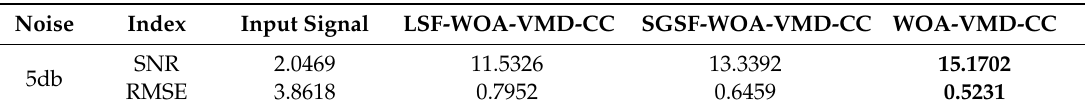
Table 4. Di ff erent denoising evaluation indexes of LSF-WOA-VMD-CC, SGSF-WOA-VMD-CC and